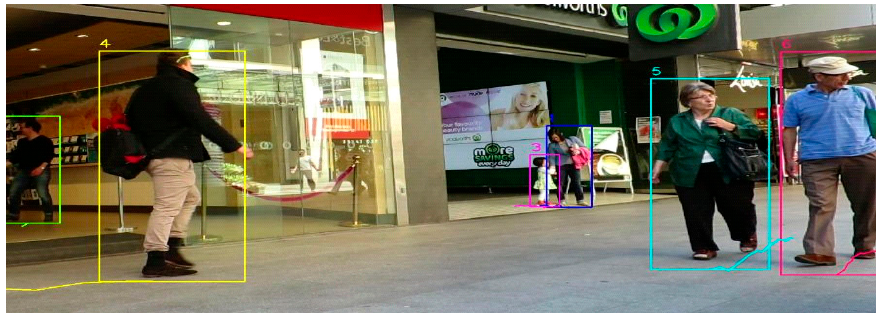
Figure 7. The proposed model (SCT) results using MOT 16-09.